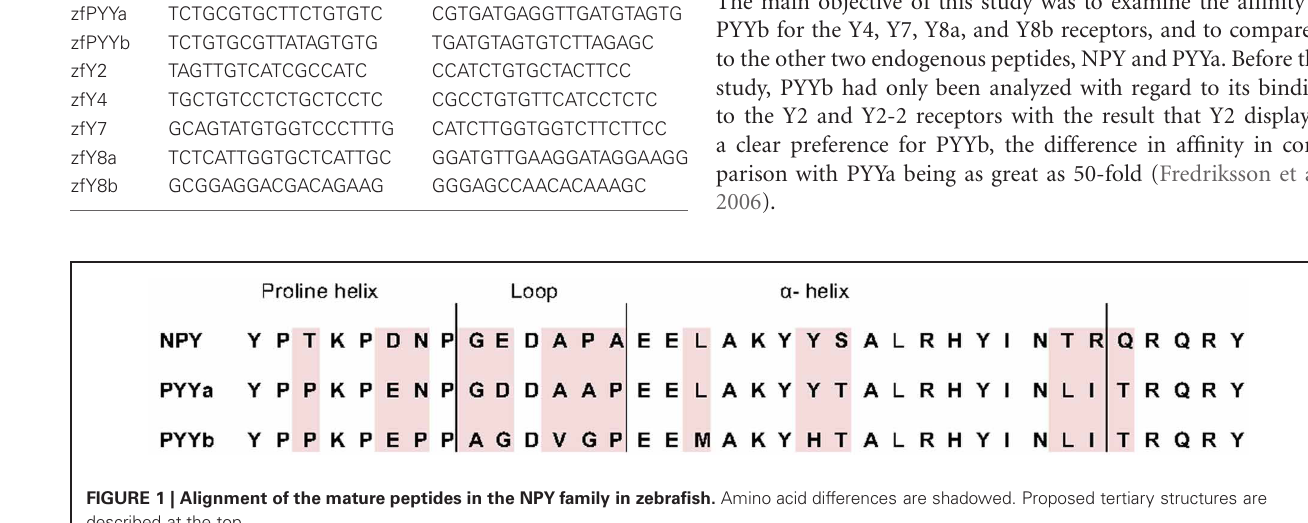
FIGURE 1 | Alignment of the mature peptides in the NPY family in zebrafish. Amino acid differences are shadowed. Proposed tertiary structures are described at the top.